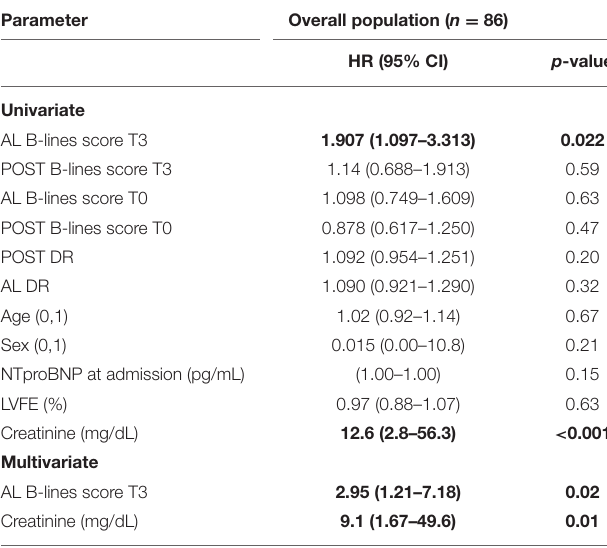
TABLE 4 | Univariate analysis of AHF hospitalization during follow-up (median length: 96 days; IQR: